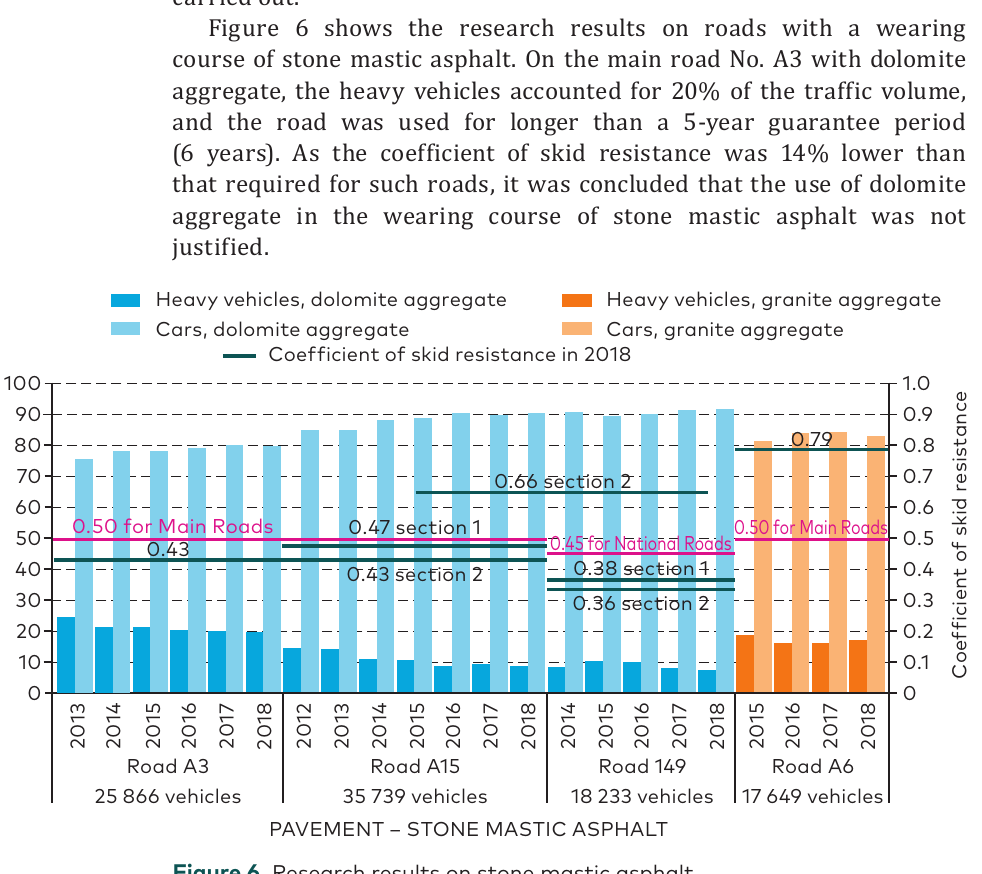
Figure 6. Research results on stone mastic